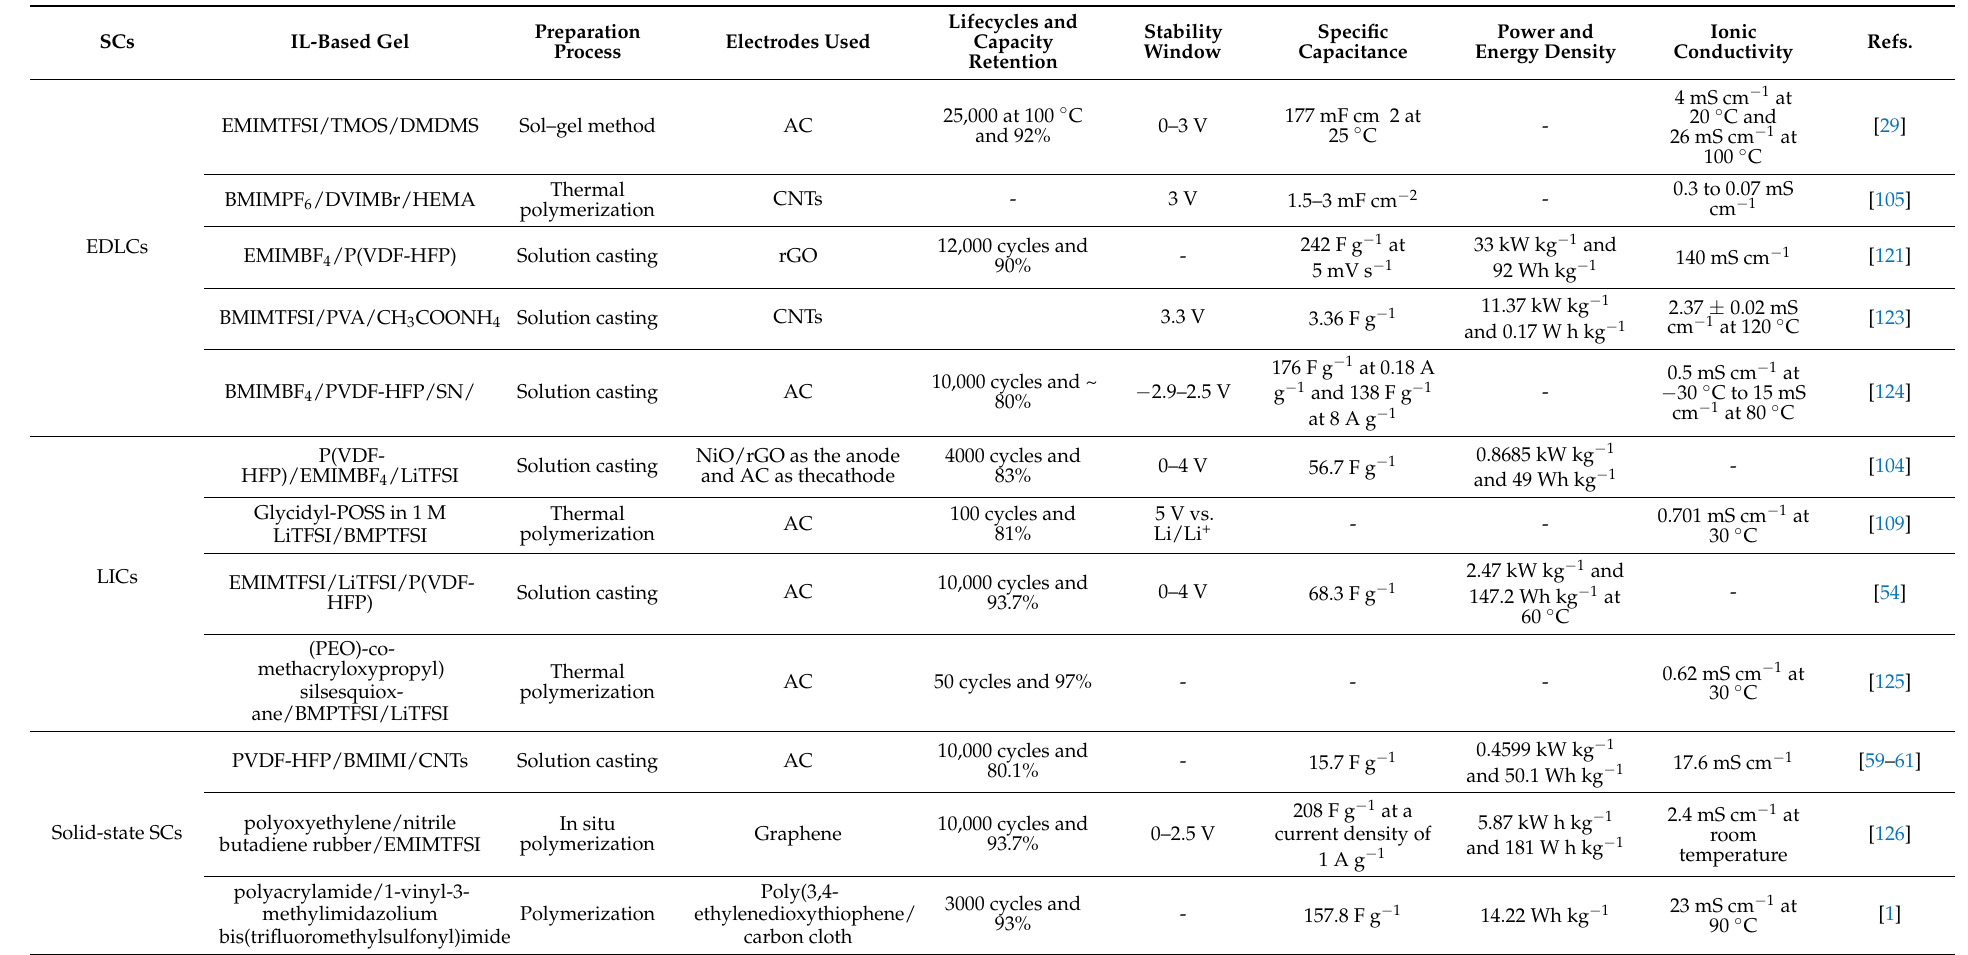
Table 3. Electrochemical performances of various IL-based gels in different